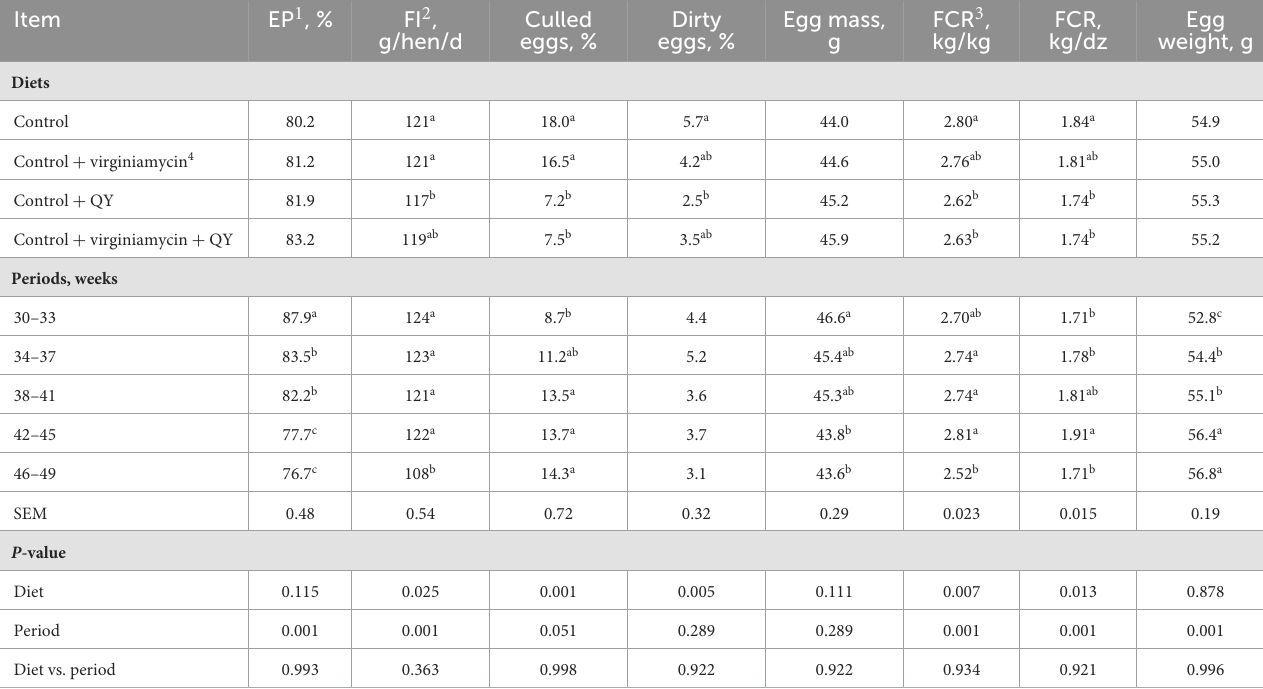
TABLE 2 Productive performance of laying breeder hens fed diets supplemented with an additive from Quillaja saponaria and Yucca schidigera (QY) from 30 and 49 weeks of